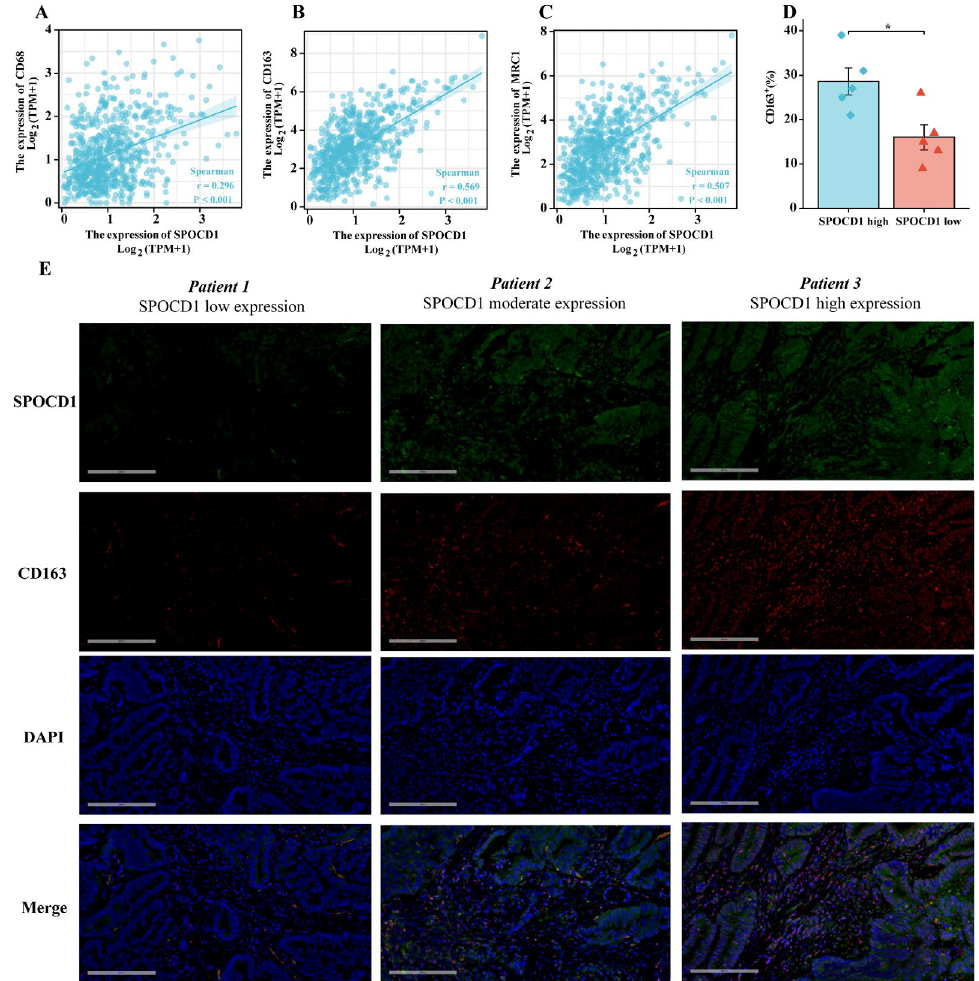
Figure 5. Correlation between SPOCD1 expression level and macrophage markers in CRC. ( A – C ) Correlation between SPOCD1 expression and macrophage markers (CD68, CD163, and MRC1). ( D ) CD163 is upregulated in SPOCD1 high-expression group. ( E ) Expression of SPOCD1 and M2 mac- rophage marker CD163 in CRC tissues (* p < 0.05).